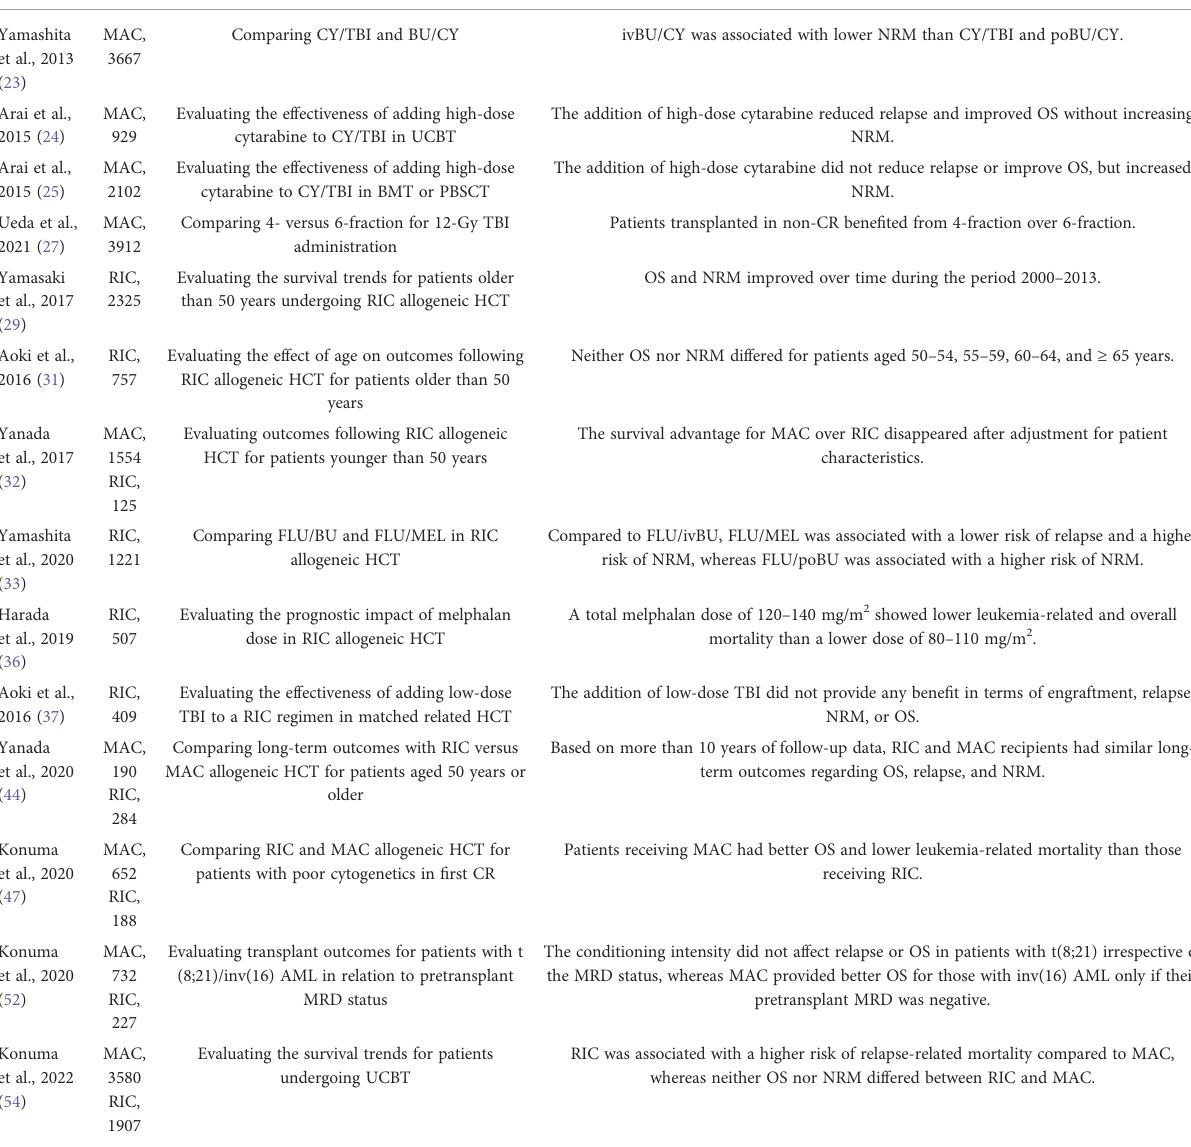
TABLE 2 Summary of the selected Japanese registry